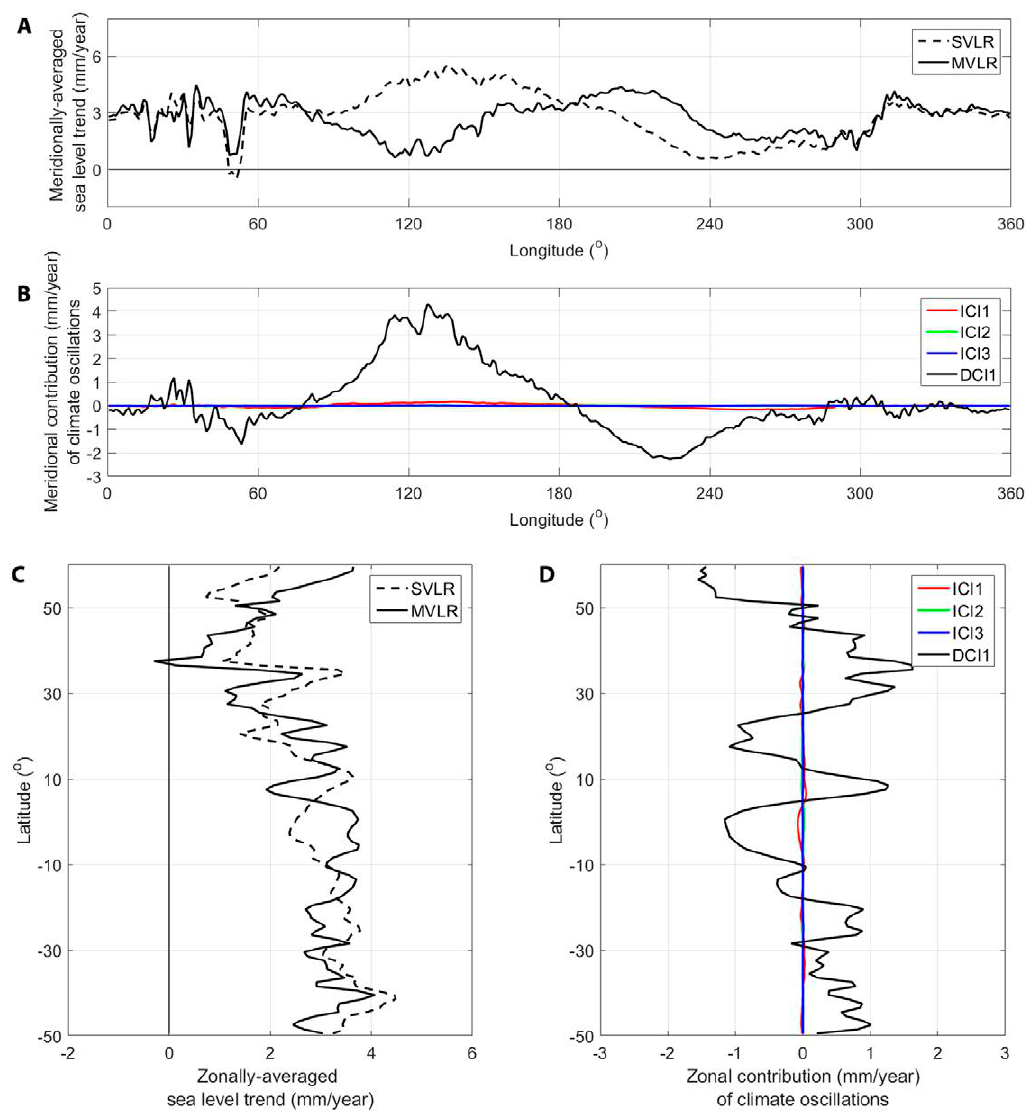
Fig. 6. –Meridional (A) and zonal (C) averaged patterns of sea level rise derived from AVISO data over the period 1993-2012 using regres- sions (SVLR and MVLR). Contributions from climate oscillations are depicted as functions of longitude (B) and latitude